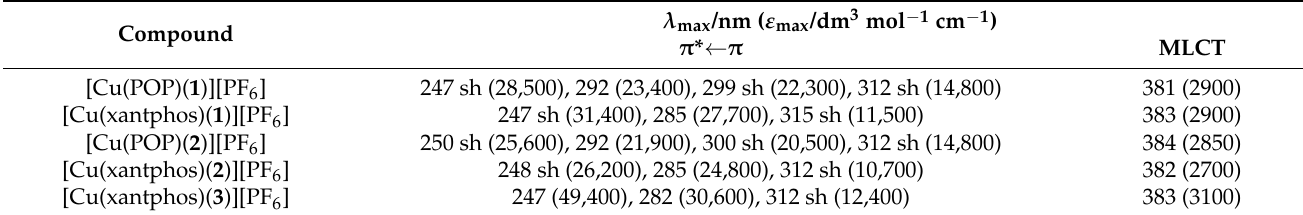
Table 3. Absorption maxima for CH 2 Cl 2 solutions of the copper(I) compounds (2.5 × 10 − 5 mol dm − 3 ). Compound